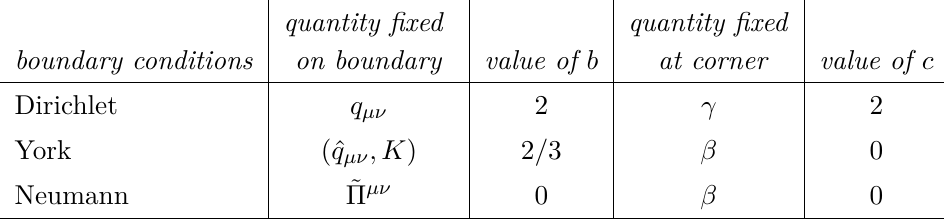
Table 2 . Different boundary conditions and their boundary and corner